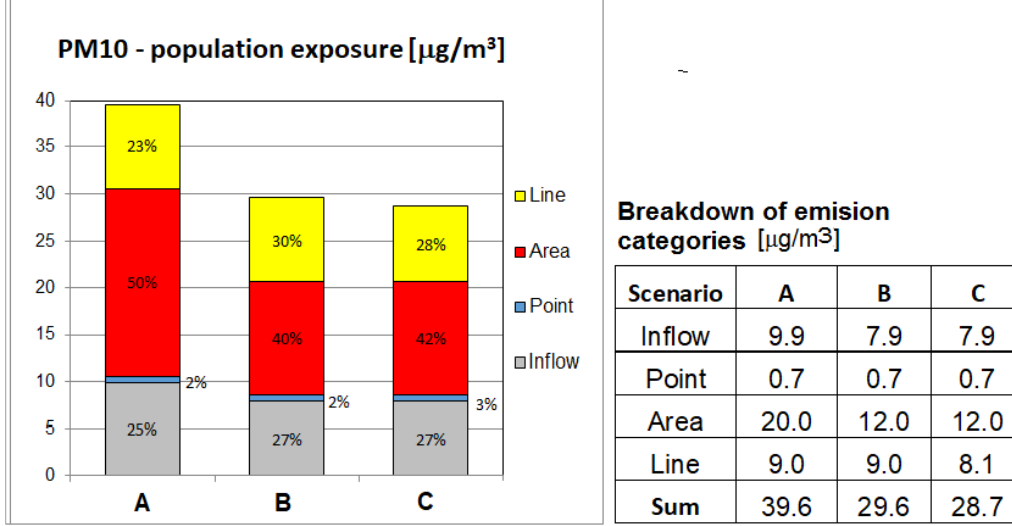
Figure 4. Modifications of PM 10 exposure.